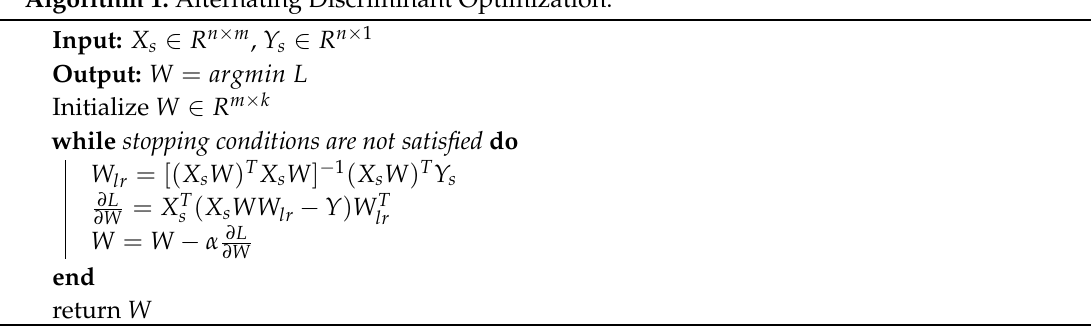
Algorithm 1: Alternating Discriminant